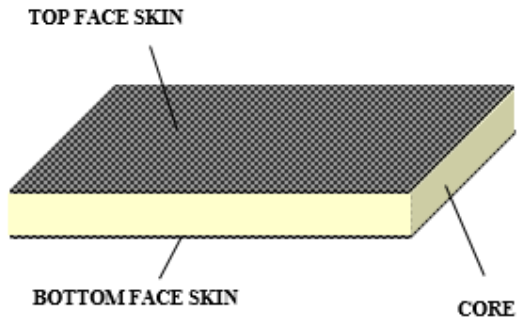
Figure 1. Schematic of a sandwich composite.